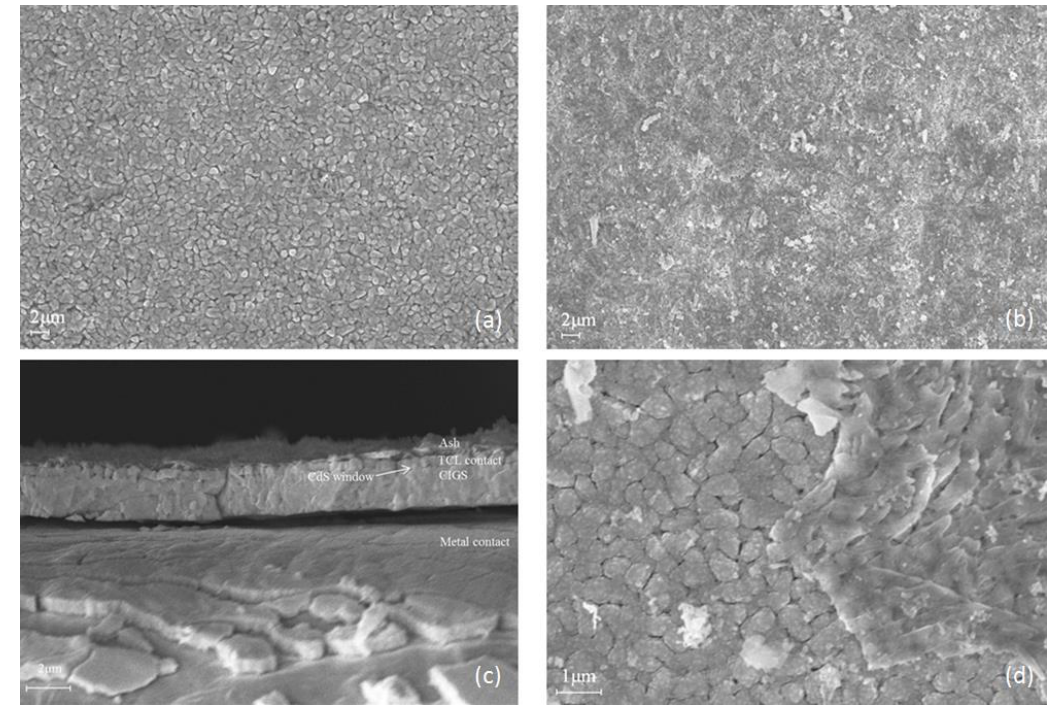
Figure 4. SEM images of CIGS cell layer. ( a ) top surface image before burning; ( b ) top surface image after burning; ( c ) cross section image after burning; ( d ) details of ash attachment.